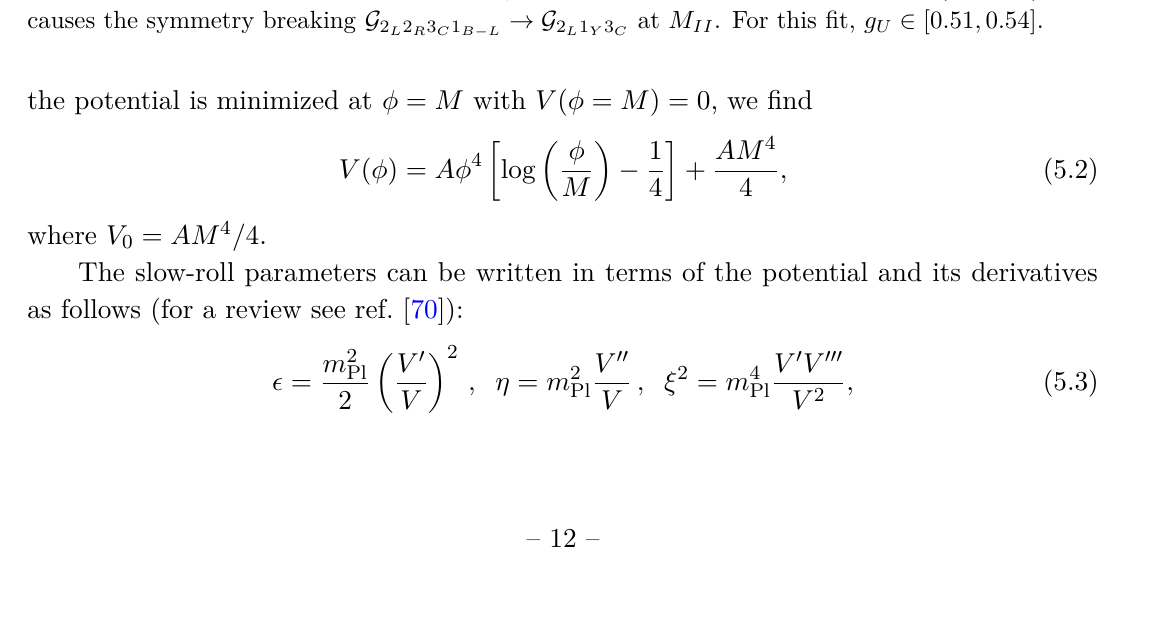
(a) Contour plot of M . (b) Contour plot of τ . X p Figure 4. Contour plots for the SO(10) breaking chain in section 3.2, where the VEV of (1 , 1 , 1 , − 2) ⊂ 126 breaks G to G . For this fit, we have g [0 . 52 , 0 . 53] , r ∈ [0 , 1] , 2 L 1 R 3 C 1 B − L 2 L 1 Y 3 C U ∈ and g ∈ [0 . 39 , 0 . 59] . (a) Contour plot of M . (b) Contour plot of τ . X p Figure 5. Contour plots for the E 6 breaking chain in section 3.3, where the VEV of (1 , 2 , 1 , 1) ⊂ 27 causes the symmetry breaking G at M . For this fit, g [0 . 51 , 0 . 54] 2 L 2 R 3 C 1 B − L → G 2 L 1 Y 3 C II U ∈